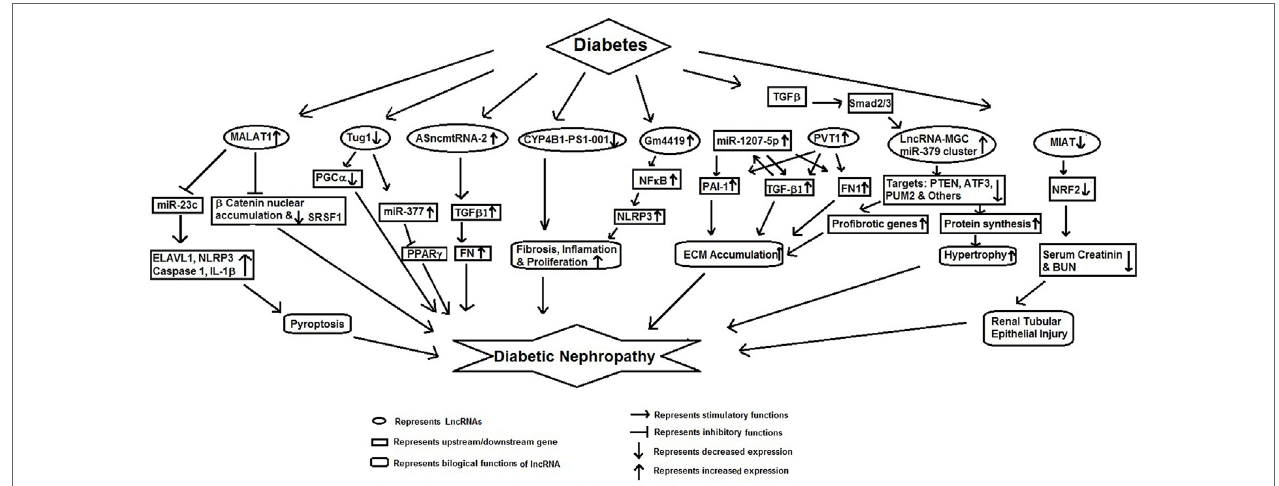
FiGURe 1 | Schematic model showing functional role of long non-coding RNAs in diabetic